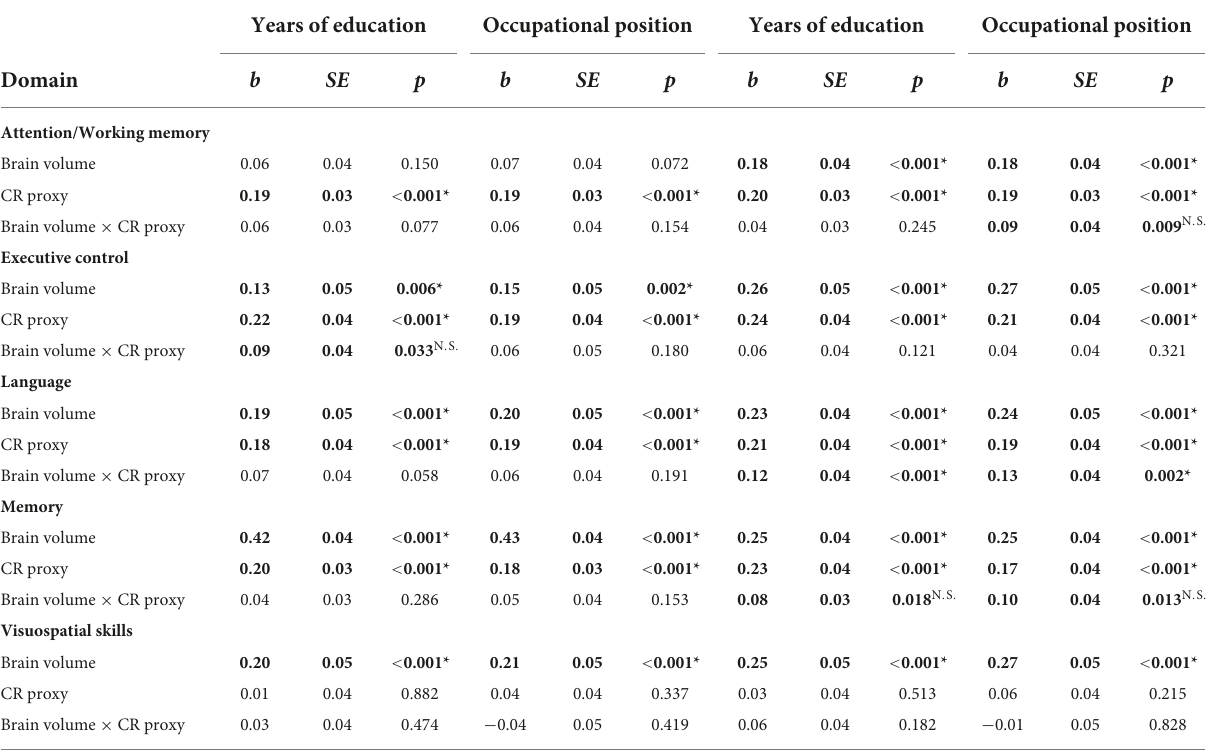
TABLE 2 Moderation analyses for participants without